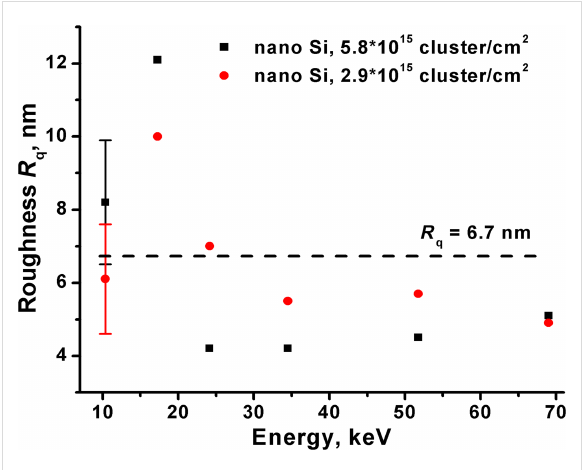
Figure 7: The roughness of the nanopowder Si versus the energy at different ion doses. The broken line represents the initial roughness.